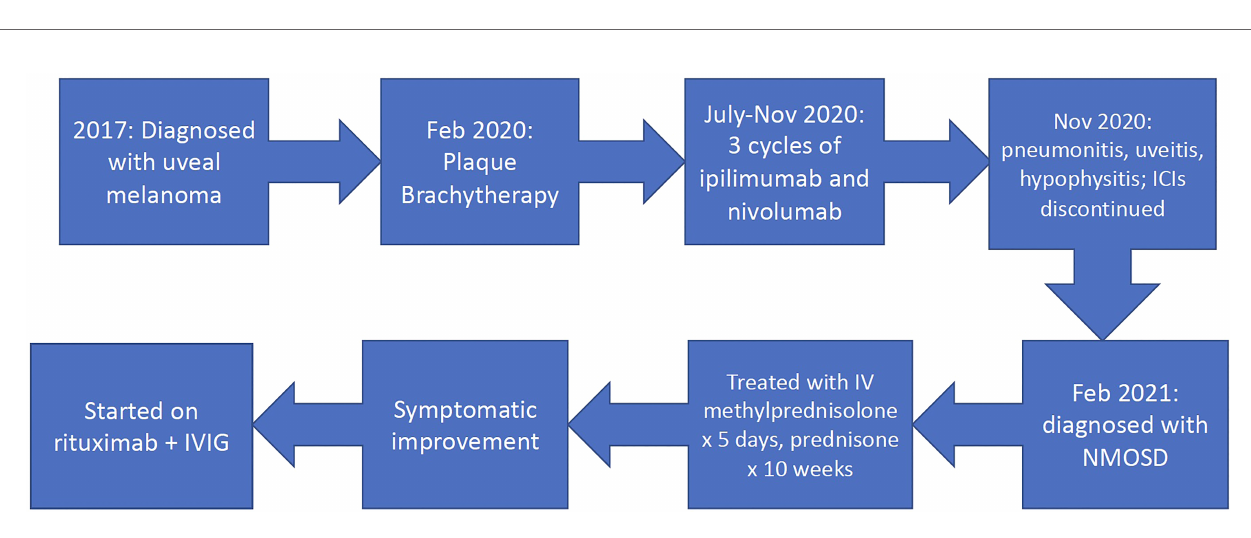
FIGURE 3 | Timeline. ICIs, immune checkpoint inhibitors; NMOSD, neuromyelitis optica spectrum disorder; IVIG, intravenous immune